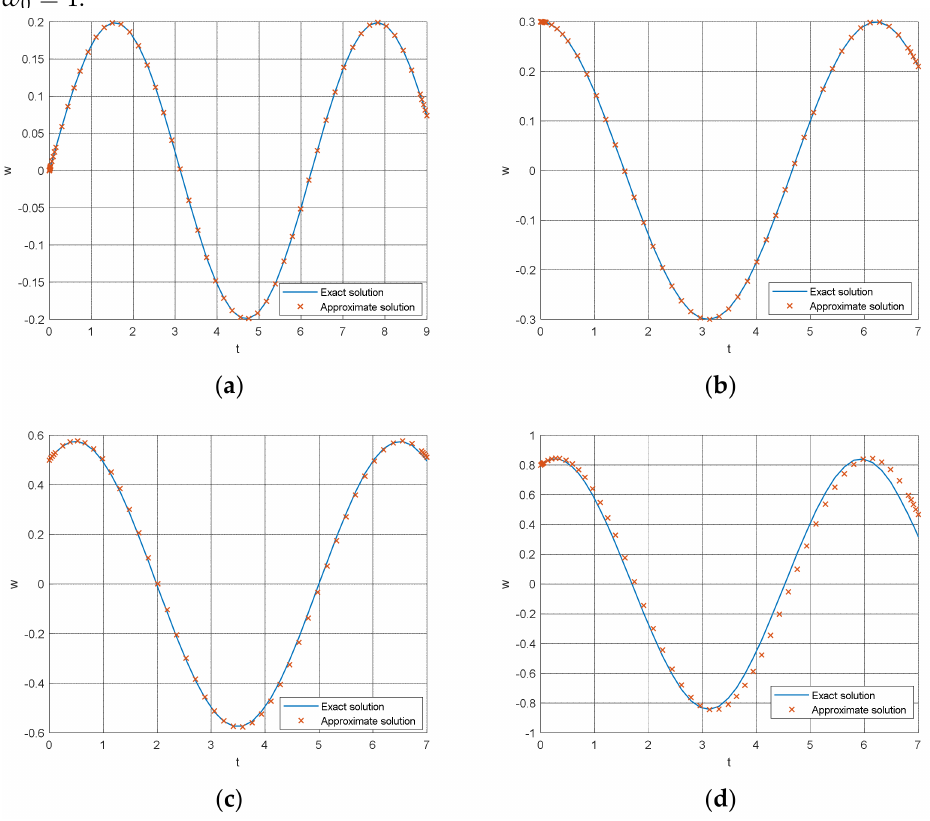
Figure 1. The approximate solution of Equation (12) vs. the exact one of Equation (5). ( a ) ( a,b ) = (0, 0.2); ( b ) ( a,b ) = (0.3, 0); ( c ) (a,b ) = (0.5, 0.3); and ( d ) ( a,b ) = (0.8,